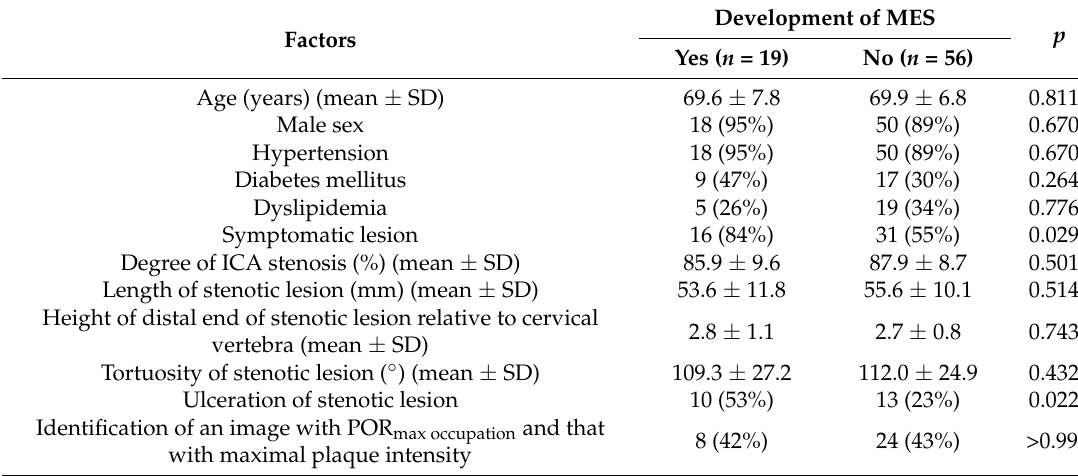
Table 3. Risk factors related to the development of MES during exposure of the carotid